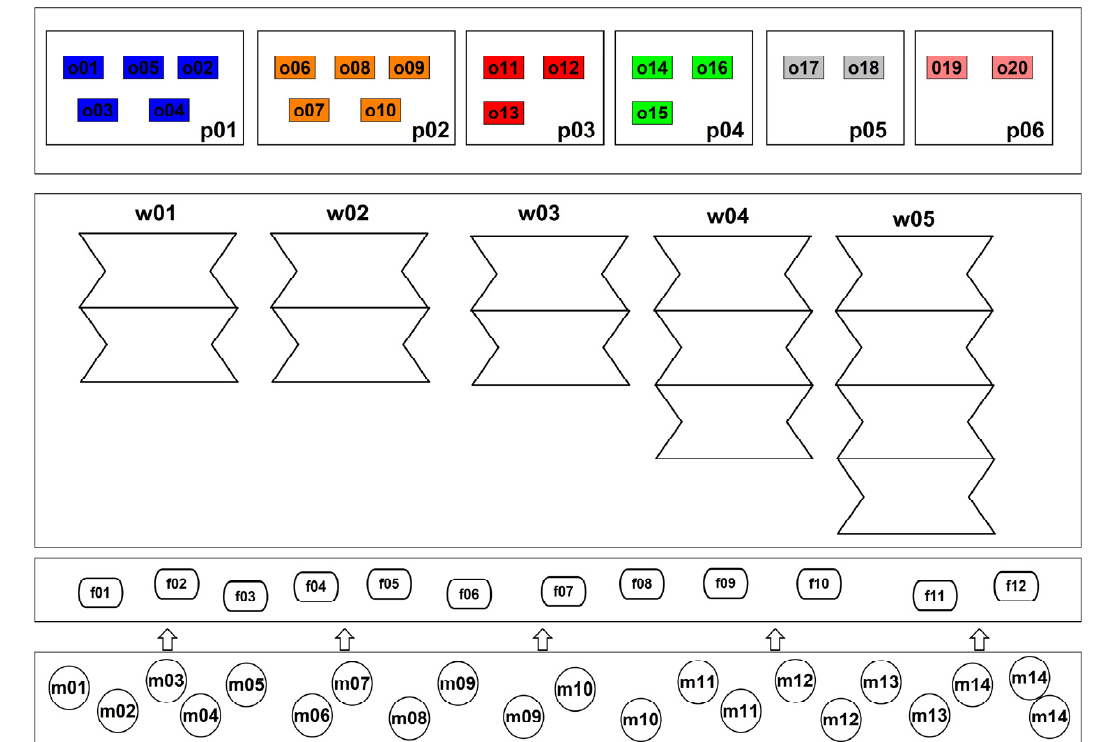
Figure 4. The layout of production system for illustrative example.